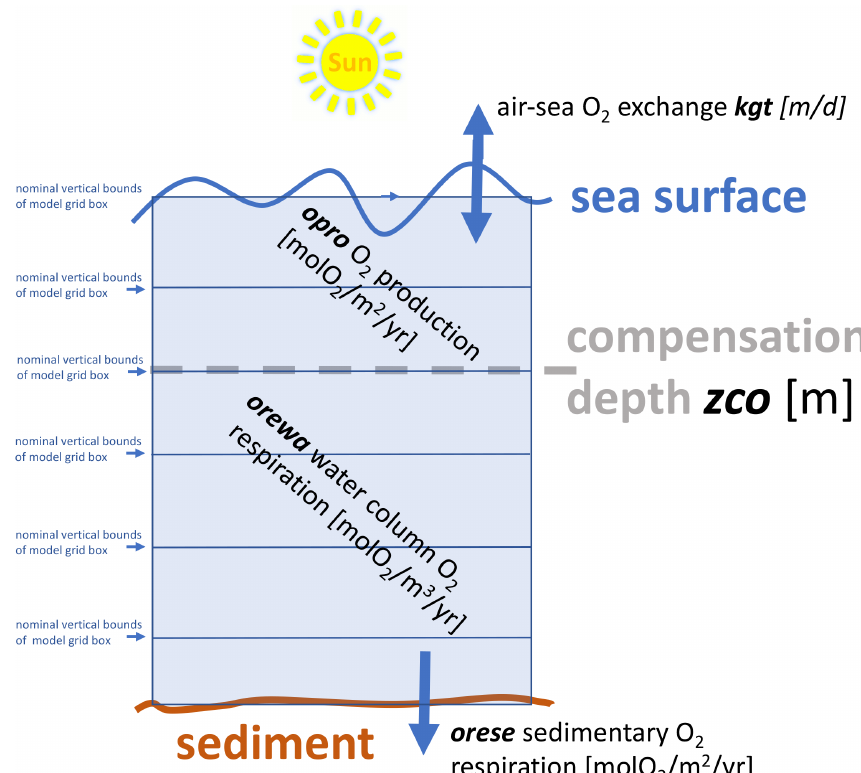
Figure 3. Schematic of dissolved oxygen module EckO 2 . EckO 2 calculates sinks and sources of oxygen throughout the water column for every grid box. These terms are then passed to the 3-D general ocean circulation that handles the effect of advection and diffusion. The velocity of the air–sea gas exchange is determined by the piston velocity kgt . Above the compensation depth zco , primary production produces oxygen at a rate prescribed by the model parameter opro . Below the compensation depth zco , respiration of organic matter consumes dissolved oxygen at a rate prescribed by orewa . At the bottom, prescribed oxygen fluxes orese mimic the oxygen consumption of the sediment that is fueled by the transfer across the water–sediment boundary. Table 2 summarizes respective parameter settings.